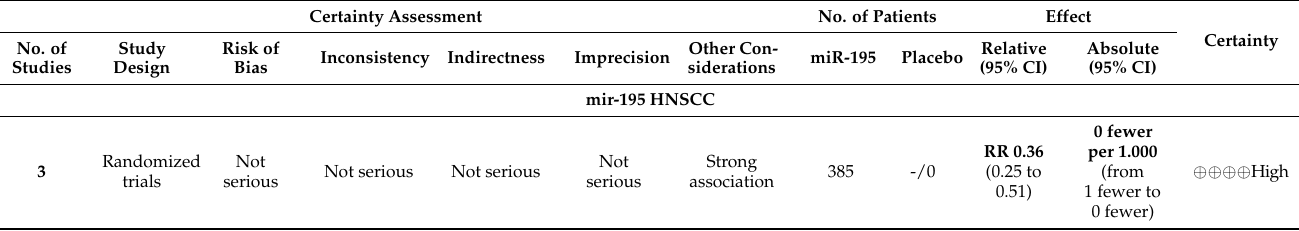
Table 3. Evaluation of GRADE pro GD.